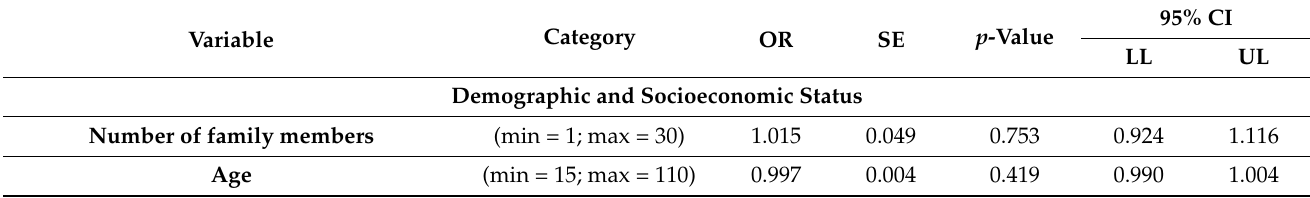
Table 2. Factors influencing Afghanistan people’s access to healthcare